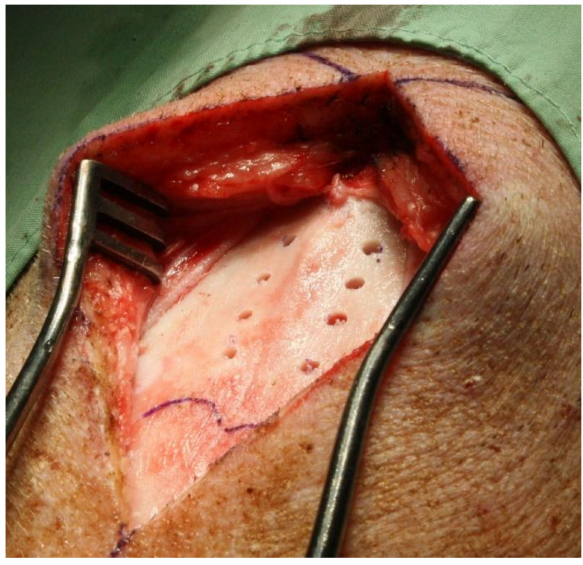
Figure 2. Calvarium after preparation of osteotomies with the standard underdrilling protocol as suggested by the manufacturer (DP2) and the extra underdrilling protocol